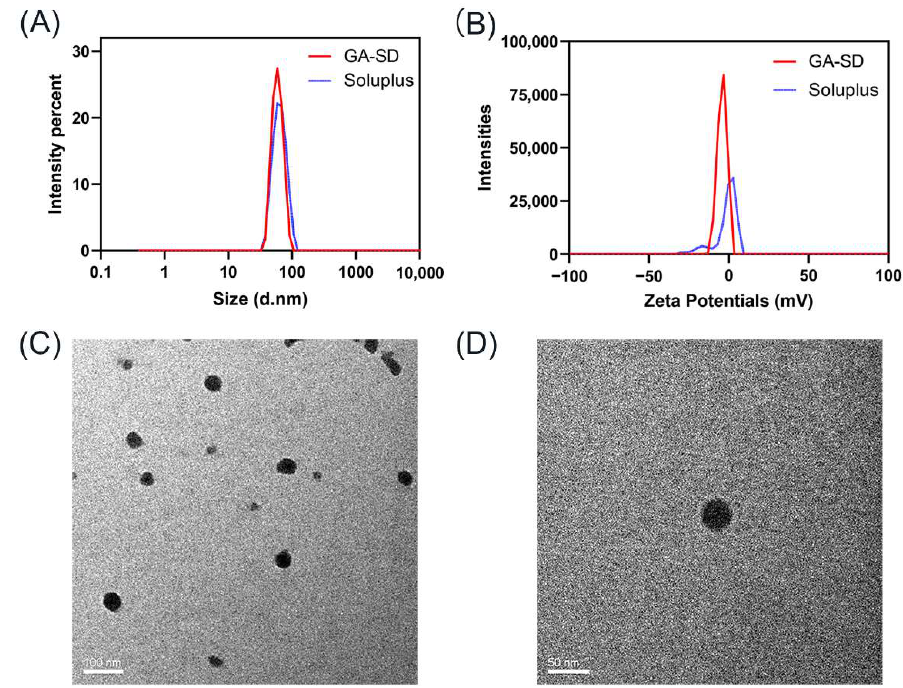
Figure 2. The particle size, Zeta Potentials and morphology of GA-SD ( A ) DLS analysis of GA-SD and Soluplus particle size. ( B ) Zeta Potentials analysis of GA-SD and Soluplus. ( C , D ) TEM analysis of GA-SD morphology.